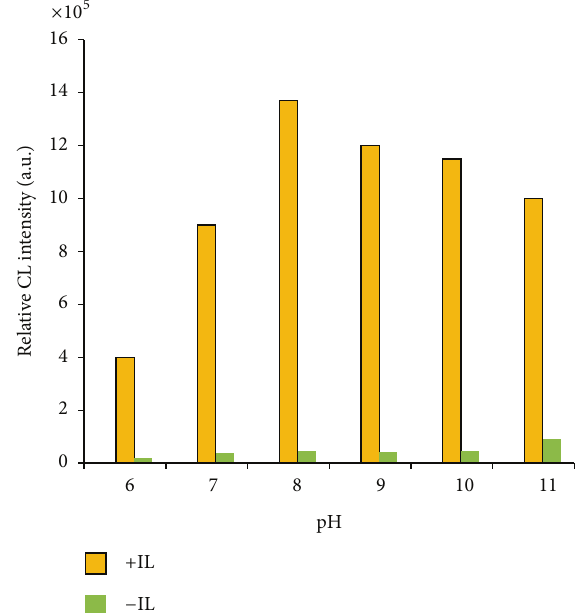
Figure 7: Maximum light intensity at pH 6.0–11.0 in the presence and in the absence of 2 M of [(1,3-Pr 2 im)Br]. Conditions: pH 8.0, ZnS QDs, 20mg L −1 , H 2 O 2 ,